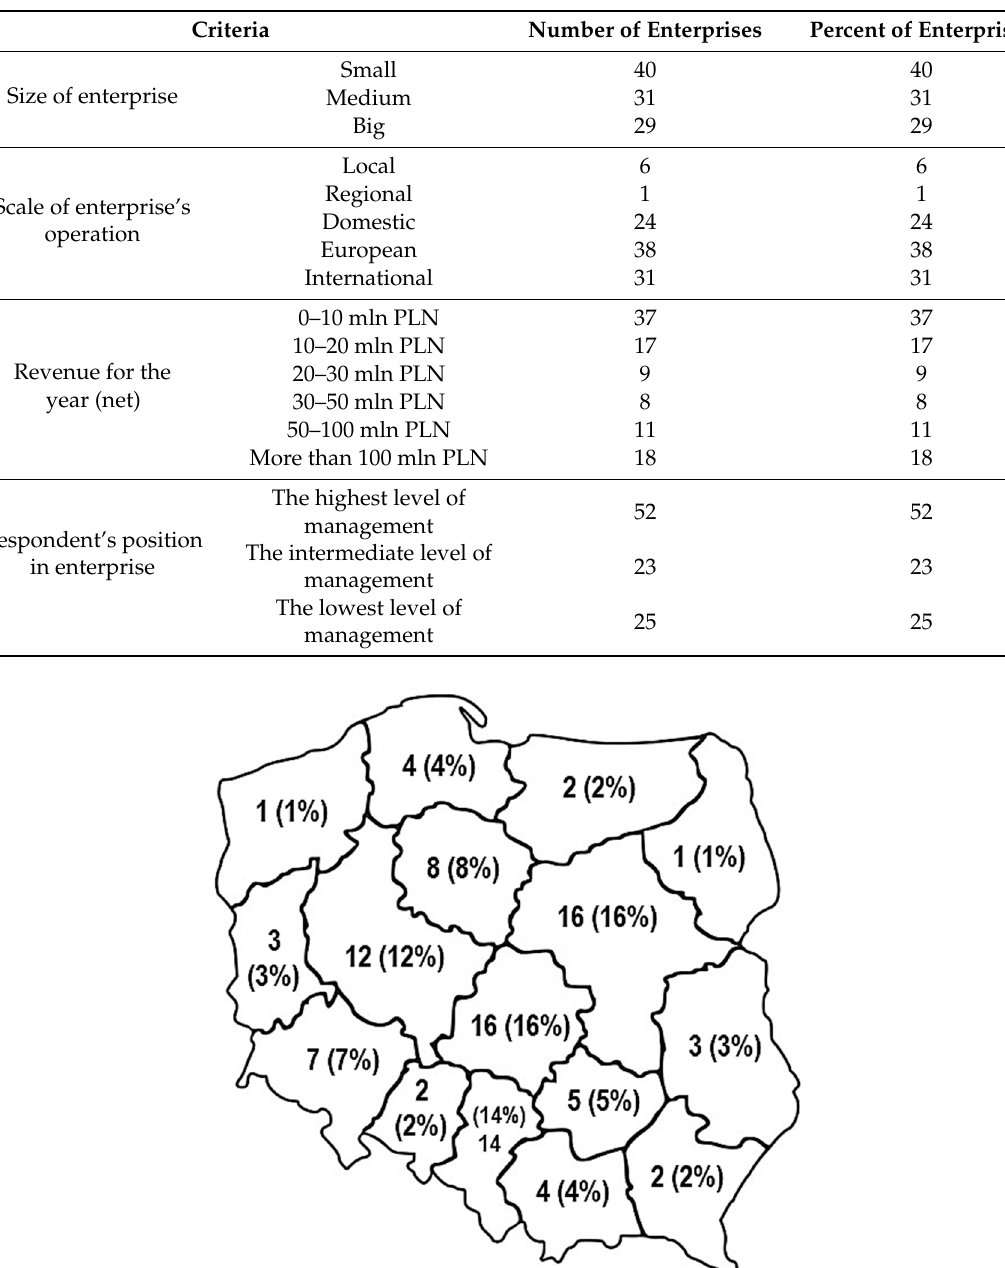
Table 6. Criteria for description of the research sample (N = 100).